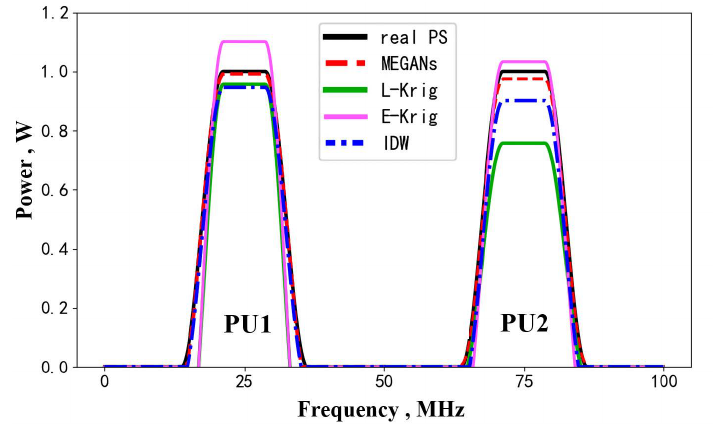
Figure 12. The power spectrum estimation results for PU1 and